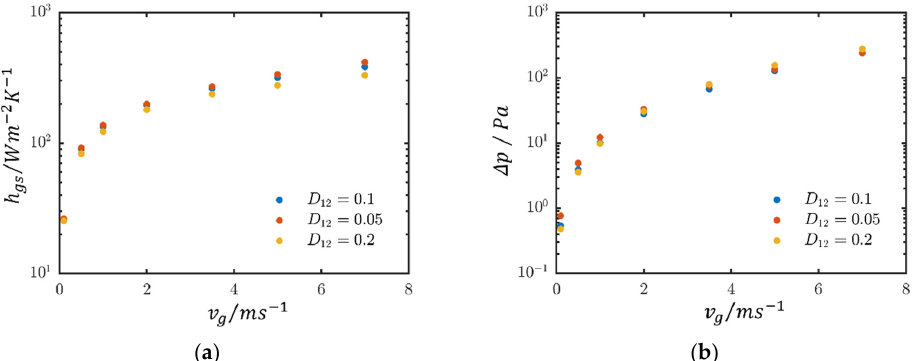
Figure 7. Variation of heat transfer coefficient ( a ) and pressure loss ( b ) as a function of inflow velocity and dimensionless diameter ratio D 12 . and dimensionless diameter ratio (cid:1830) (cid:2869)(cid:2870) .